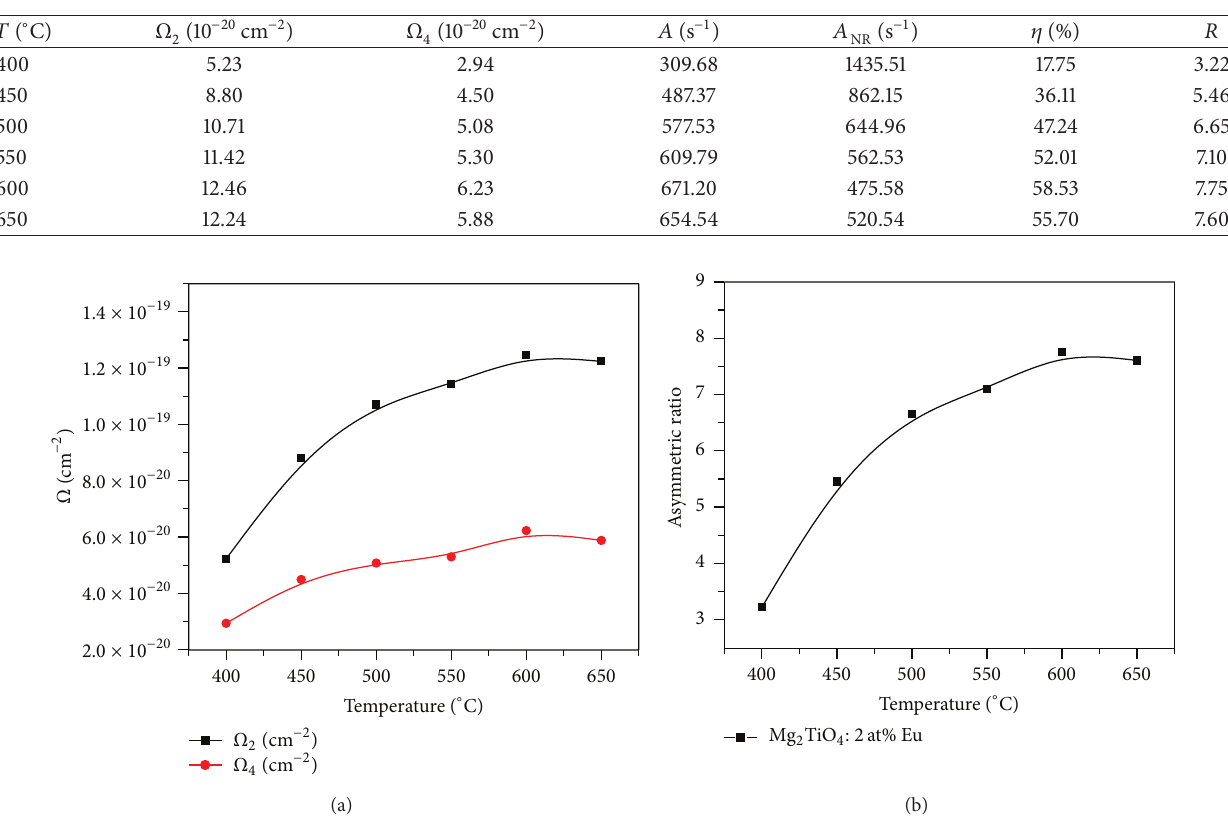
Table 2: Intensity parameters, radiative and nonradiative emission probabilities, quantum efficiencies, and asymmetry ratios of Eu 3+ emission TiO nanoparticles prepared at different temperatures from 400 ∘ C to 650 ∘ C. from Mg 2 4